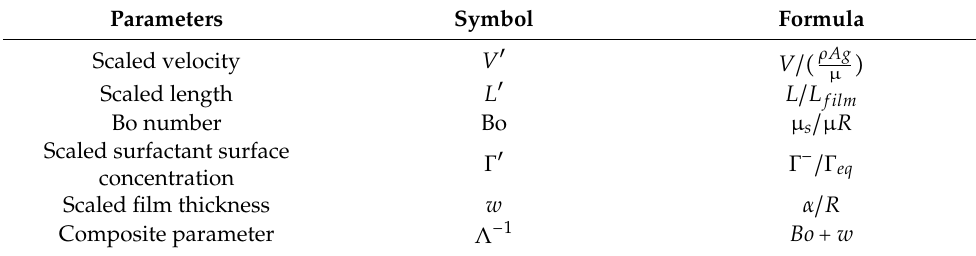
Table 2. Dimensionless parameters [7,9]. Parameters Symbol Formula ) Scaled velocity V ′ V /( ρ Ag µ Scaled length L ′ L / L film Bo number Bo µ s / µ R Scaled surfactant surface Γ concentration